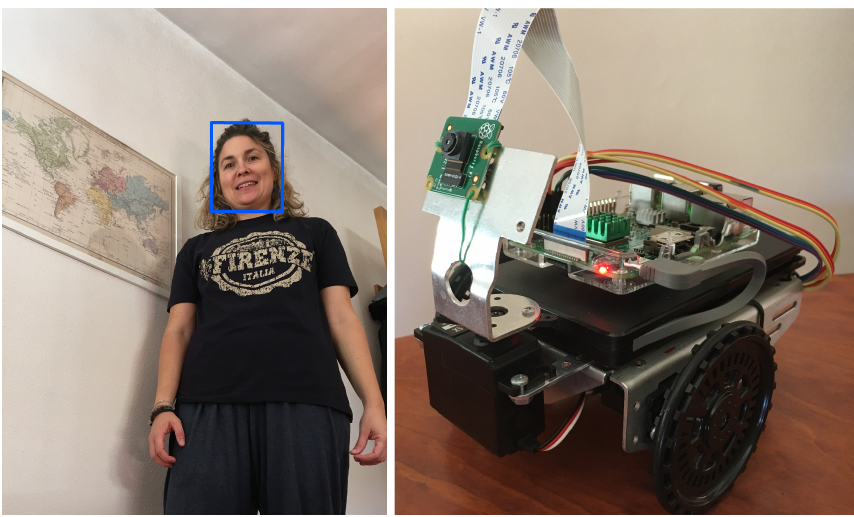
Figure 17. PiBot configuration to detect human faces.